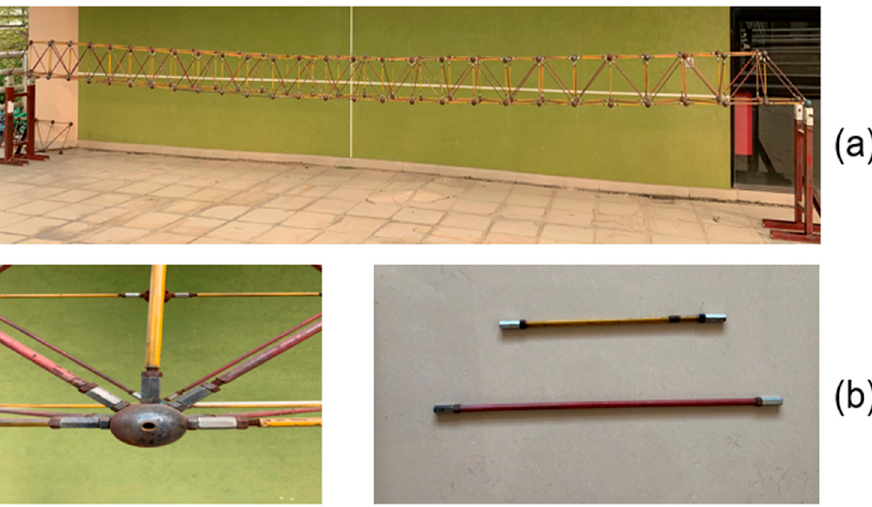
Figure 5. ( a ) Bridge model; ( b ) Model components.